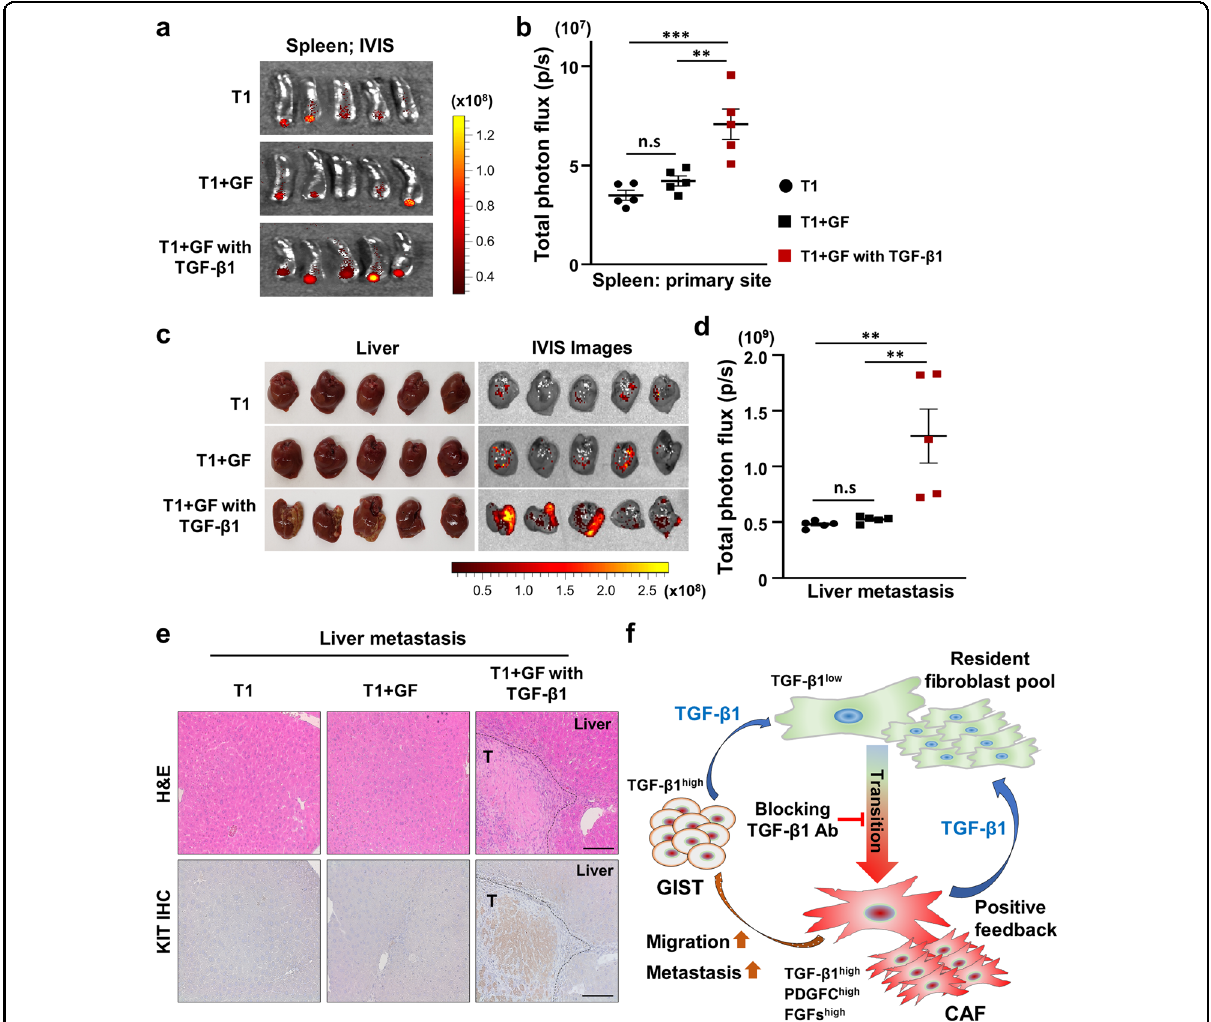
Fig. 6 TGF- β 1-mediated transition of GF to CAF promotes GIST metastasis. a , b Effects of a transition from GF to CAF on the murine spleen-to- liver metastasis model. The mice were injected with GFP-labeled T1, T1 + GF, and T1 + GF pre-treated with TGF- β 1. After 3 weeks, all mice were sacri fi ced. The harvested spleens and livers from each mouse were analyzed using the IVIS imaging system. IVIS images ( a ) of the spleen and quanti fi cation ( b ) analyzed from total photon fl ux (p/s) of the spleen. p Values were represented by ANOVA analysis. ** p < 0.01, *** p < 0.001. n.s. nonsigni fi cant. c Photographic images (left) and IVIS images (right) of the liver in the indicated group. d Quantitative data were analyzed by total photon fl ux (p/s) on the metastatic liver. p Values were represented by ANOVA analysis. ** p < 0.01. e Representative H&E images (top) and IHC (bottom) stained with anti-KIT antibody in the tumor sections collected from livers. Scale bars, 100 µm. f Proposed model of TGF- β 1-mediated transition of GFs to CAFs in the GIST stroma. TGF- β 1 secretion from CAFs and GIST cells enhances a GF-to-CAF transition, which promotes GIST migration via paracrine signaling